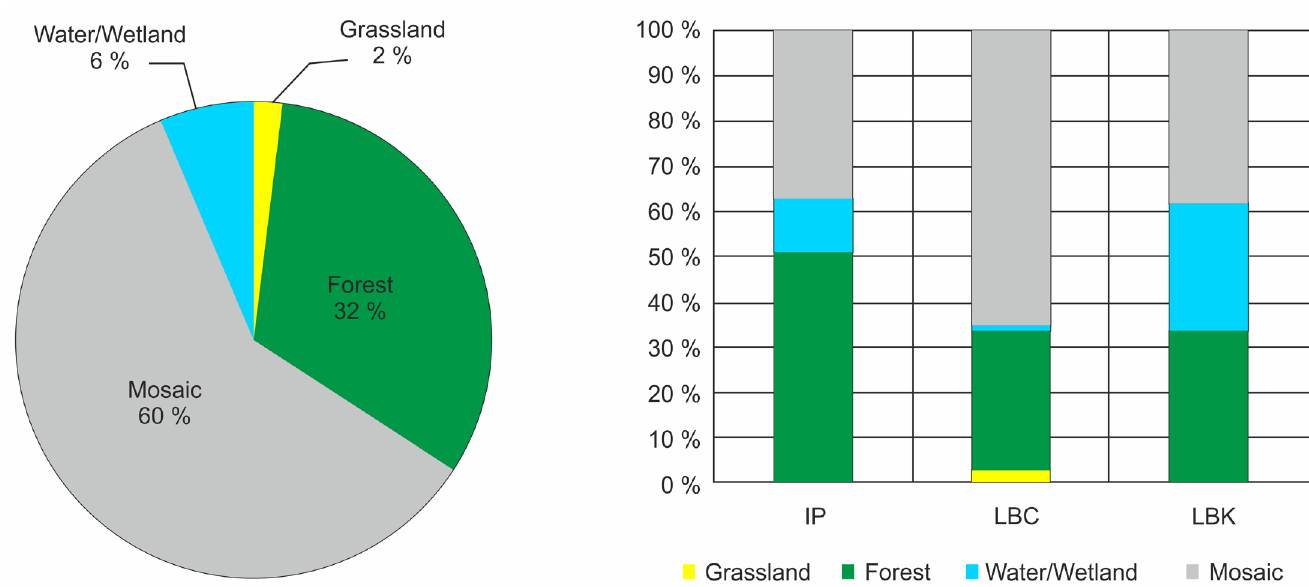
Figure 5: Proportions of target ecosystems in local TSES elements as total (left) and its components